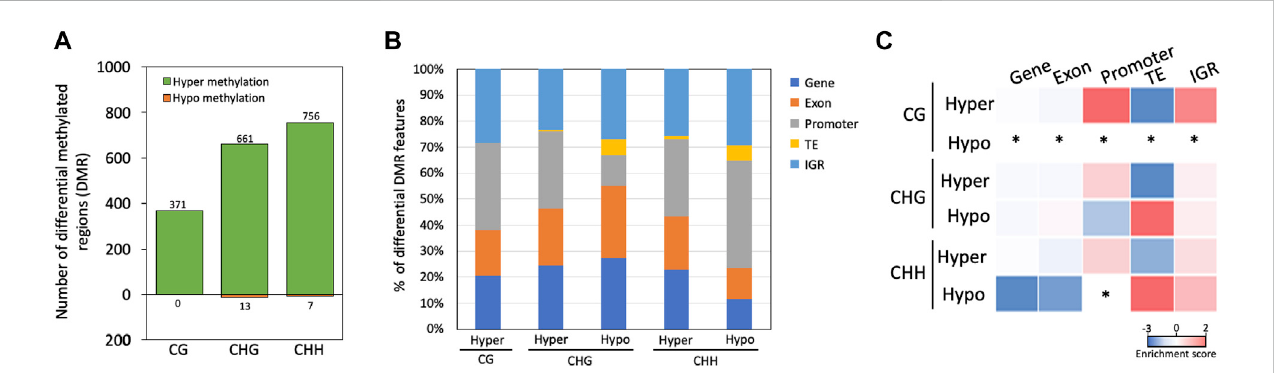
FIGURE 5 Identi fi cation and characterization of differentially methylated regions between conidia and mycelium in Bb-NCHU-157. (A) Hypermethylated and hypomethylated regions based on a comparison of the mycelium and conidial stages; (B) proportions of different methylated contexts that are hypermethylated and hypomethylated in different regions; and (C) enrichment analysis of DMRs. * = nd.